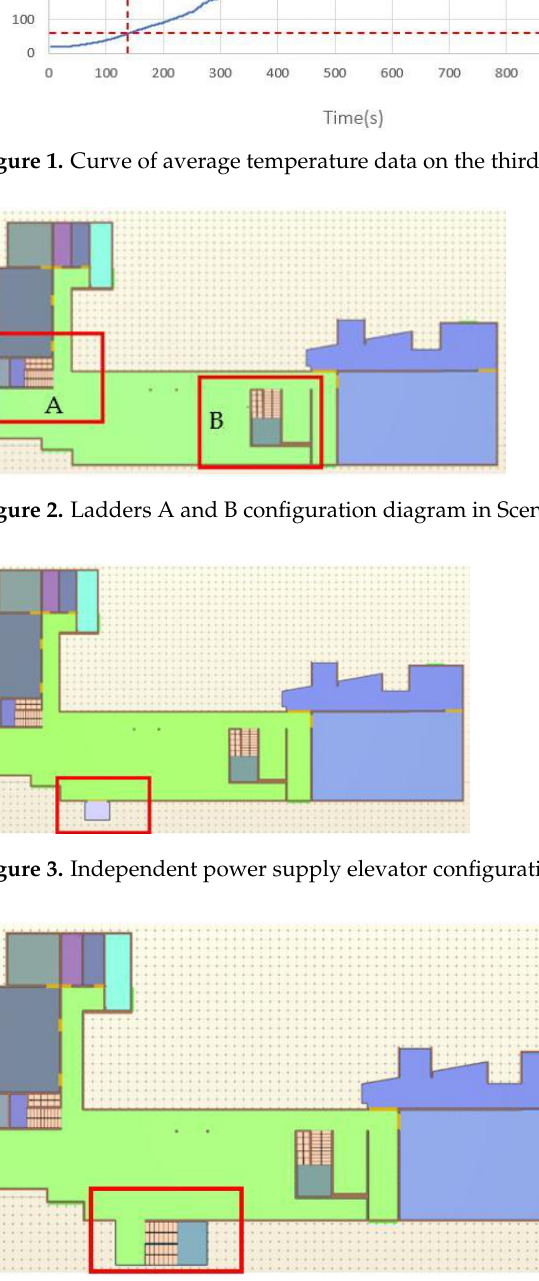
Figure 3. Independent power supply elevator configuration diagram in Scenario B. Figure 4. External ramp evaluation configuration diagram in Scenario